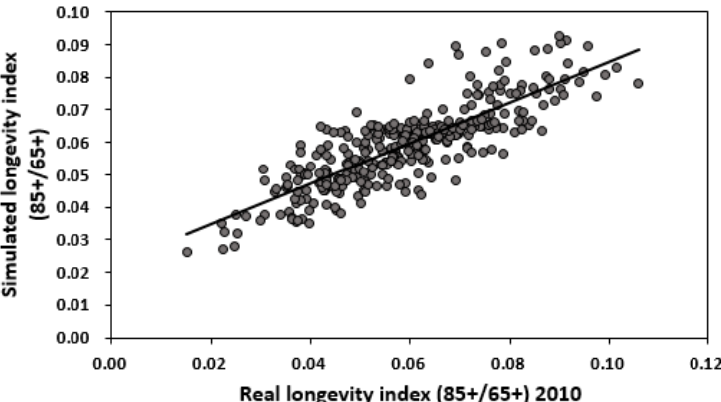
in soil, altitude and per capita sea fish consumption in 2000. Int. J. Environ. Res. Public Health 2017 , 14 , 1195